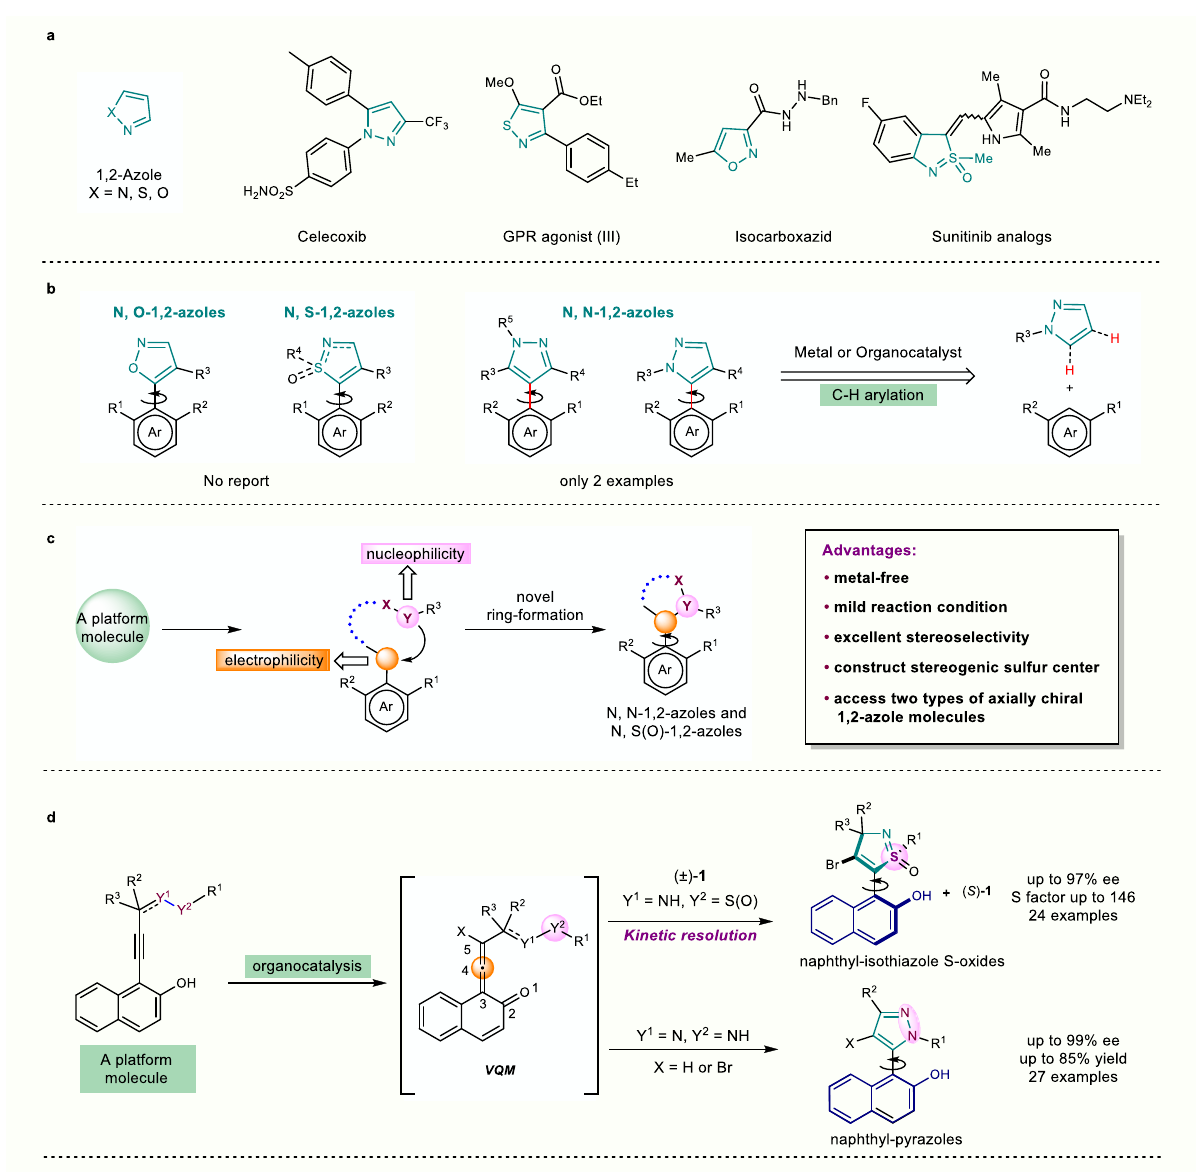
Fig. 1 Background and project synopsis. a Examples of 1,2-azole structures in drugs and bioactive molecules. b Synthesis status of axially chiral compounds containing 1,2-azole structures. c Our strategy: novel construction of axially chiral compounds containing 1,2-azoles. d This